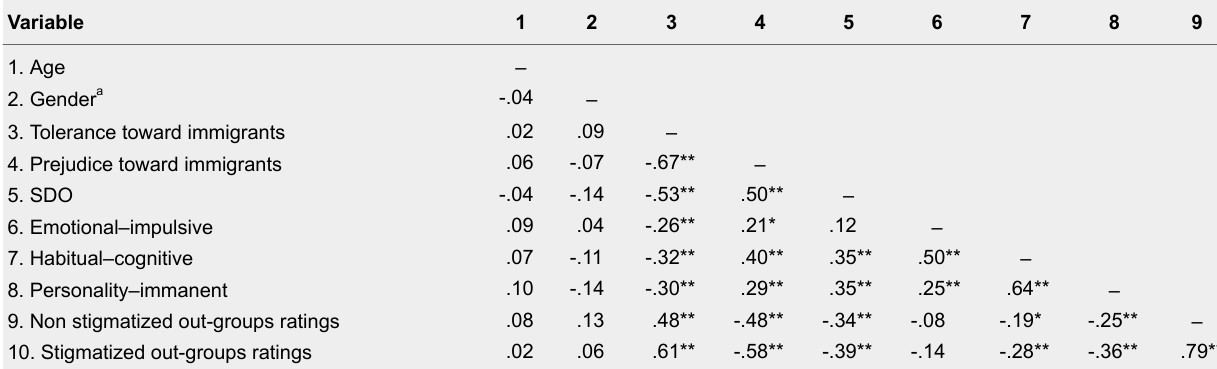
Correlations Among all Variables Used in the Regression Analyses